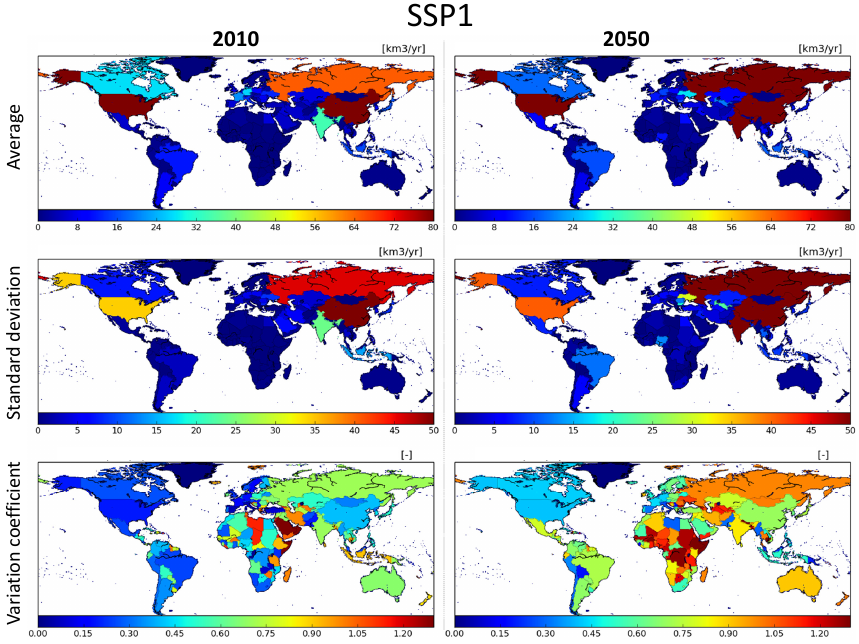
Figure A5. Global maps of projected industrial water withdrawals calculated by the global water models H08, PCR-GLOBWB, and Wa- terGAP for the years 2010 and 2050, respectively, under the SSP1 scenario. Avr, Std, and Std/Avr denote average, standard deviation, and coefficient of variations.